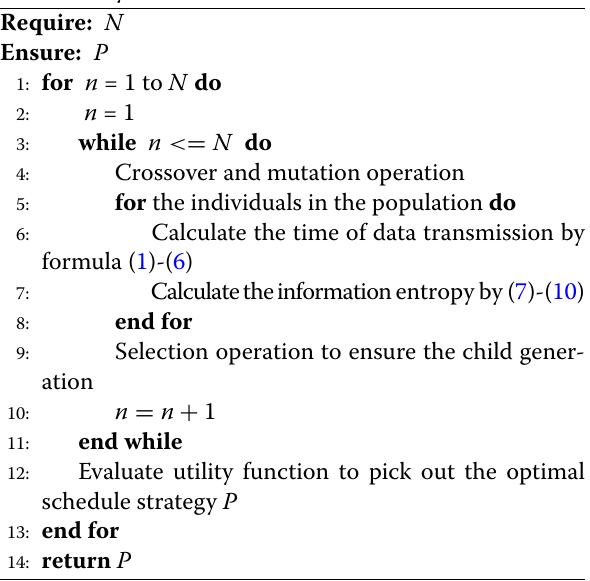
Algorithm 3 Time-Efficient Data Offloading